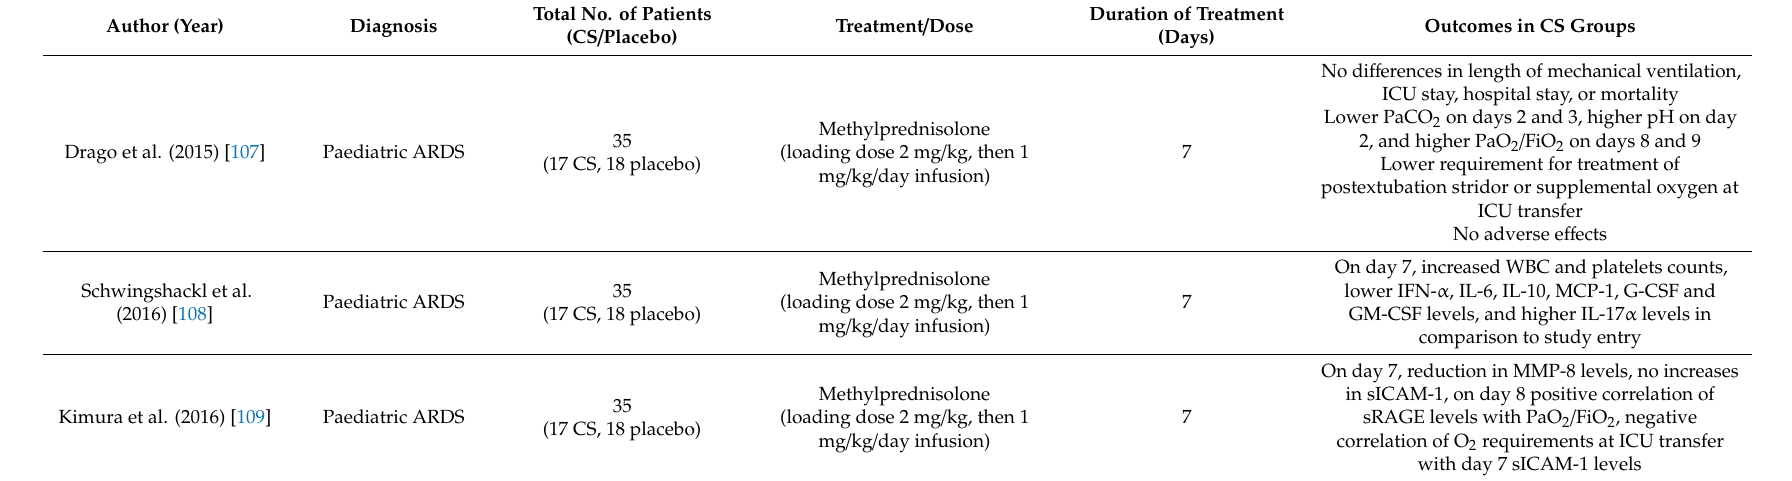
Table 2. Randomized controlled trials of CS in paediatric patients with